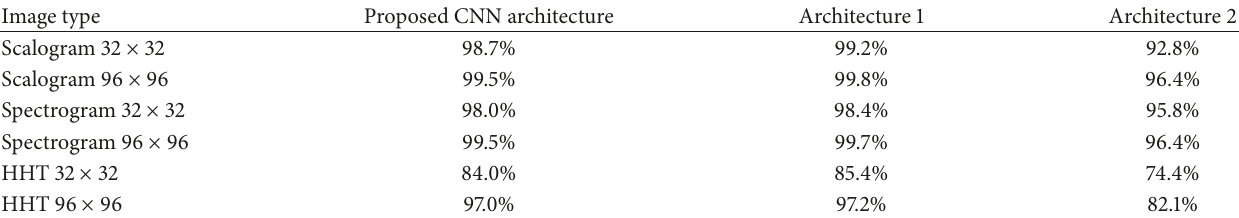
Table 25: 𝐹 -measure for CWR data